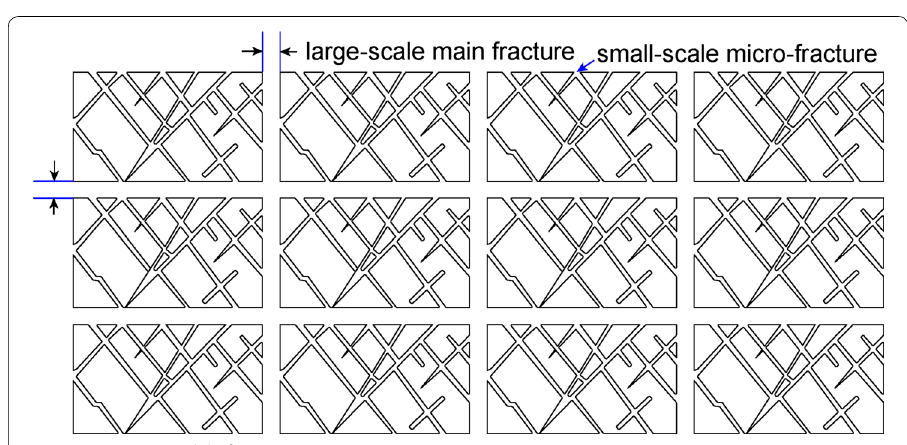
Fig. 14 Porosity model of CO 2 storage in EGS